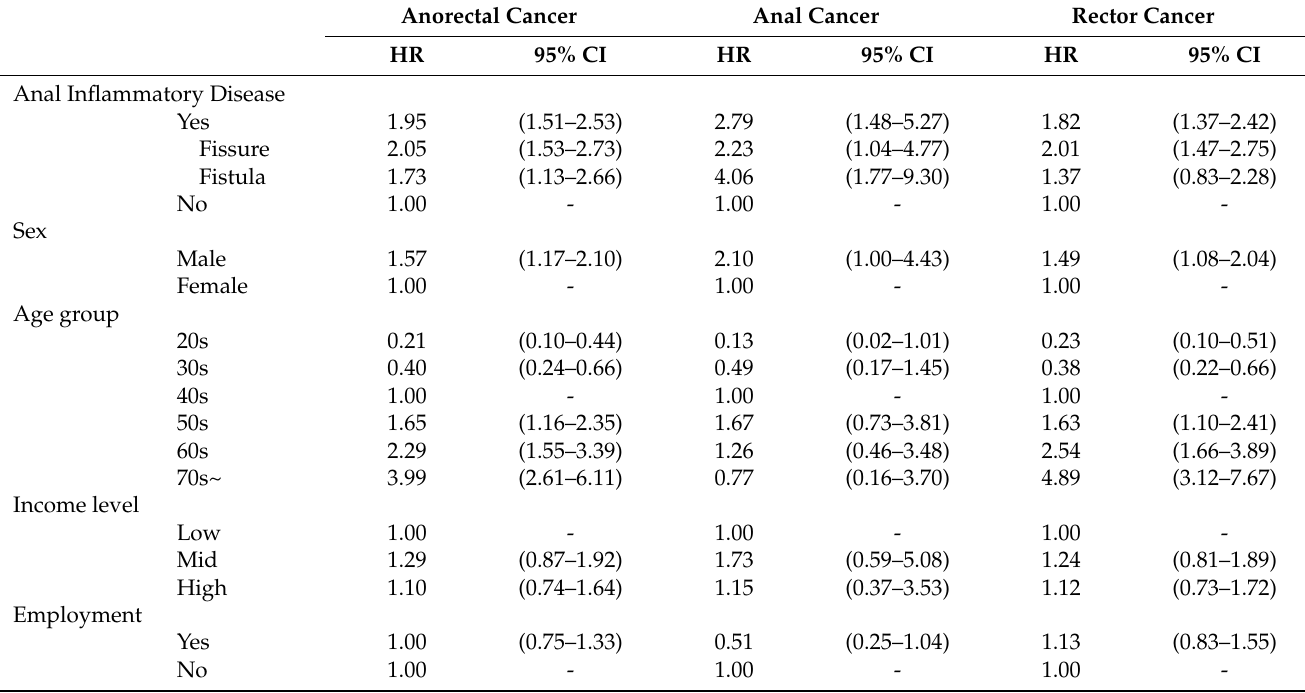
Table 2. Result of Cox Hazzard Regression on Anorectal Cancer and sub-cancers. Anorectal